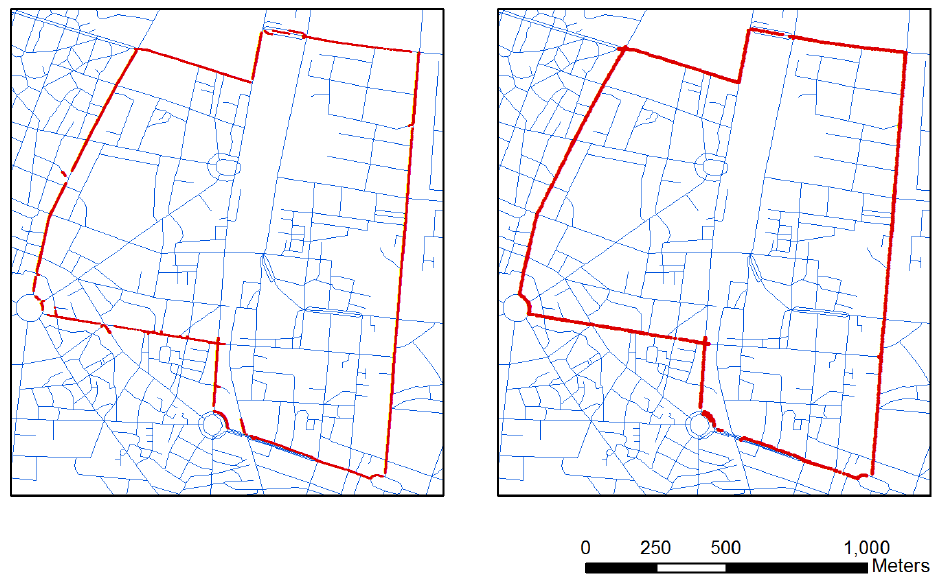
Figure 5. Point-to-curve ( Left ) and curve-to-curve ( Right ) map-matching